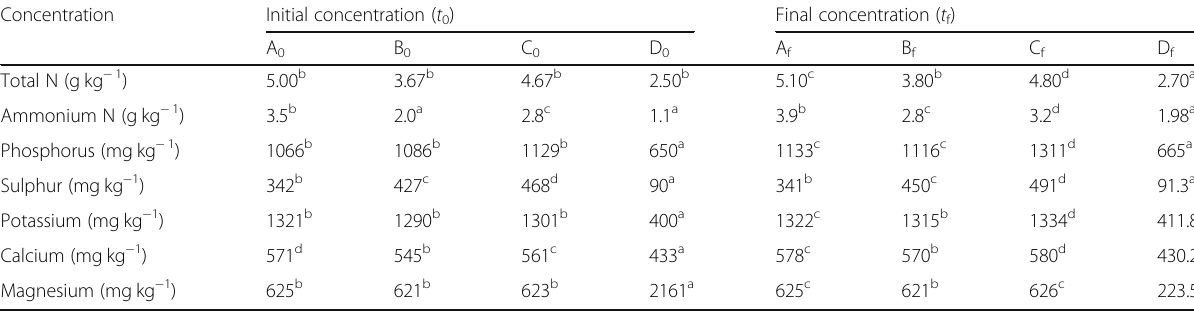
Table 4 Nutrient and light metal concentration of feedstock ( t 0 ) and digestate ( t f ) Concentration Initial concentration ( t 0